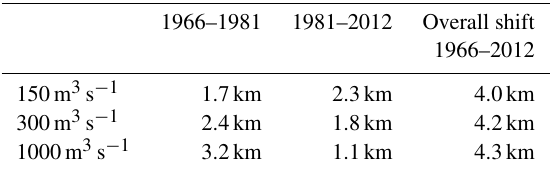
Table 4. The average landward shift of the 5psu isohaline in the hindcast simulations, based on regression analysis (see Fig.